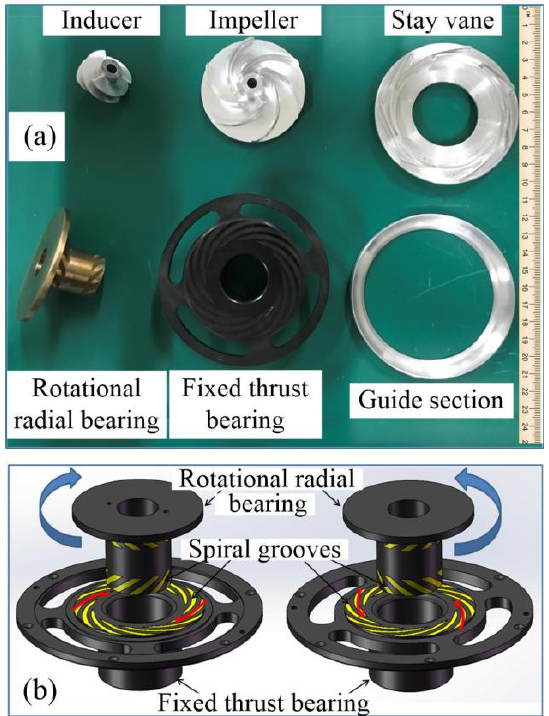
Figure 2. ( a ) Main hydraulic components of high-speed centrifugal pump. ( b ) Details of Hydrodynamic Bearings.